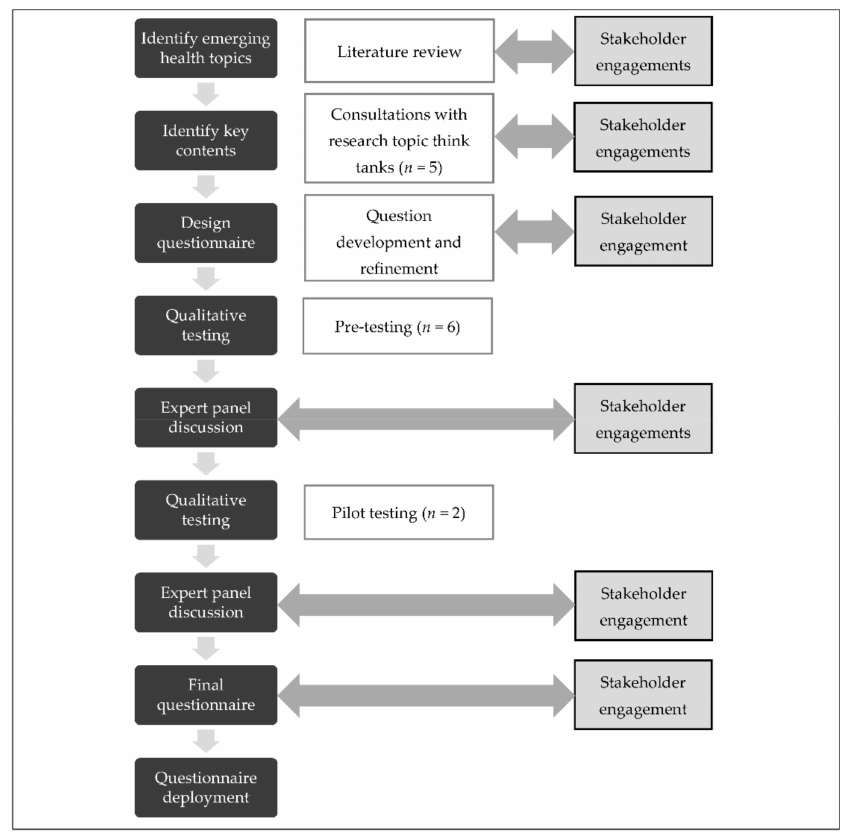
Figure 1. The process adopted for redesigning the questionnaire for the national health